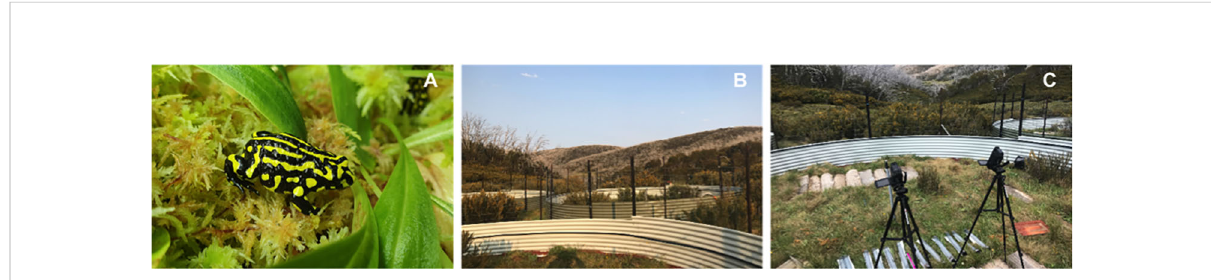
FIGURE 1 (A) Adult Southern Corroboree frog, Pseudophryne corroboree , (B) Soft-release fi eld enclosures located in Kosciuszko National Park, NSW, and (C) video recording set-up and release apparatus within a fi eld enclosure. Photograph A is courtesy of A.J. Silla, photographs B and C are courtesy of P.G.